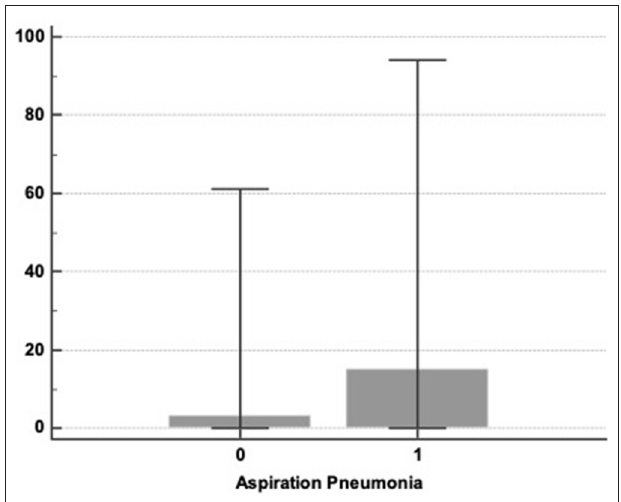
FIGURE 1 | α -amylase levels in mini-BAL at admission and aspiration pneumonia represented by box plot 25–75: 0: no aspiration pneumonia; 1: